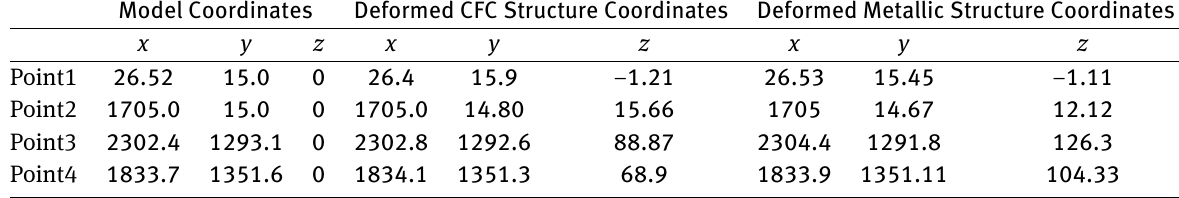
Table 2: Coordinates of CFC and Metallic Canard (All Coordinates are in mm) Model Coordinates Deformed CFC Structure Coordinates Deformed Metallic Structure Coordinates